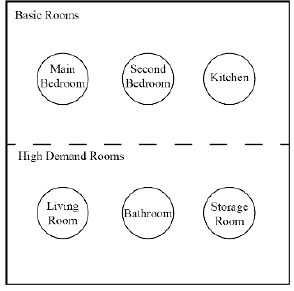
Figure 4. Primary functions.